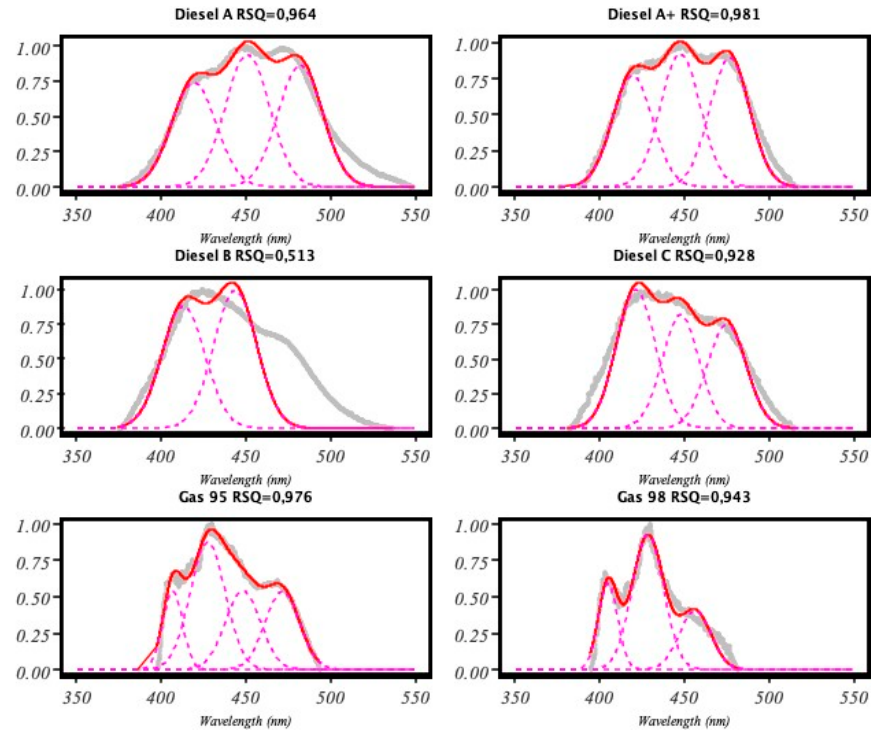
Figure 6. Results obtained from our implementation of the pseudocode shown in Figure 5.